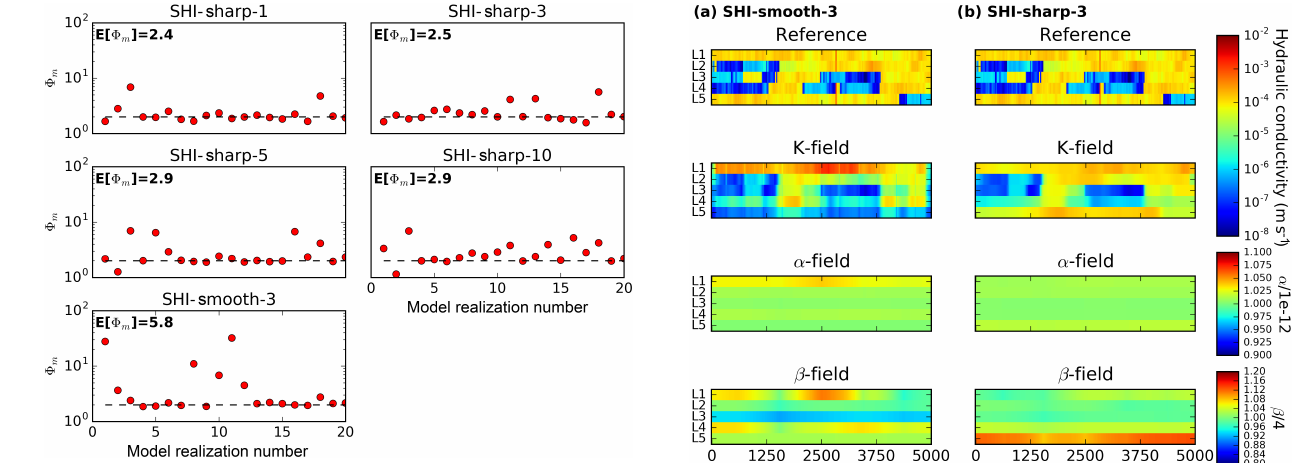
Figure 7. East–west cross section for model realization number 20. (a) shows the parameter fields for the SHI-smooth-3 calibrated model. (b) shows the parameter fields for the SHI-sharp-3 calibrated model. The first row shows the reference K -field, the second row shows the estimated K -field, and the third and fourth rows show shape factors of the petrophysical relationship for α and β , respec-